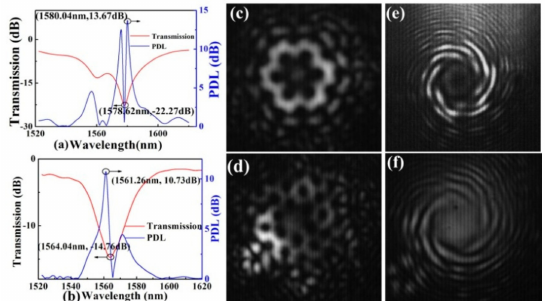
Figure 32. Transmission spectrum of the ( a ) Dip 1 ( b ) and Dip 2 ; ( c , d ) measured beam profiles and ( e , f ) interference patterns of the Dip 1 and Dip2 in the HLPFG, i.e., OAM + 6 and OAM + 5 modes generated by the HLPFG in the PCF [14].